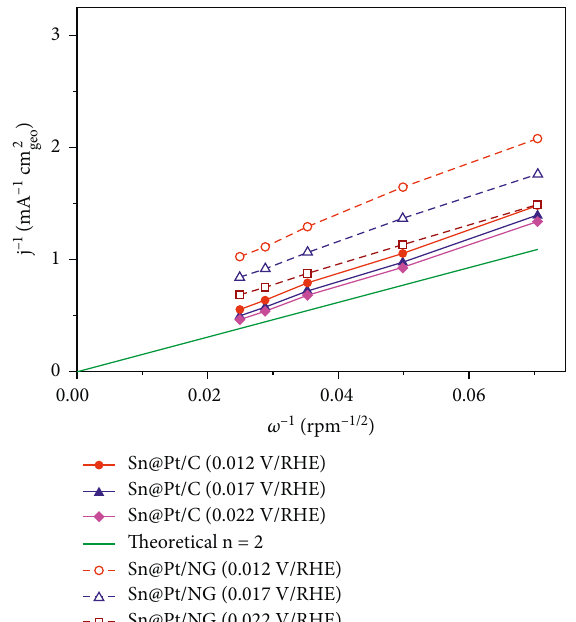
Figure 6: Koutecky–Levich plots of the HOR at Sn@Pt/C and Sn@Pt/NG at several ω . Potentials: 0.012, 0.017, and 0.22V/RHE. The theoretical slope of n � 2 is also shown.